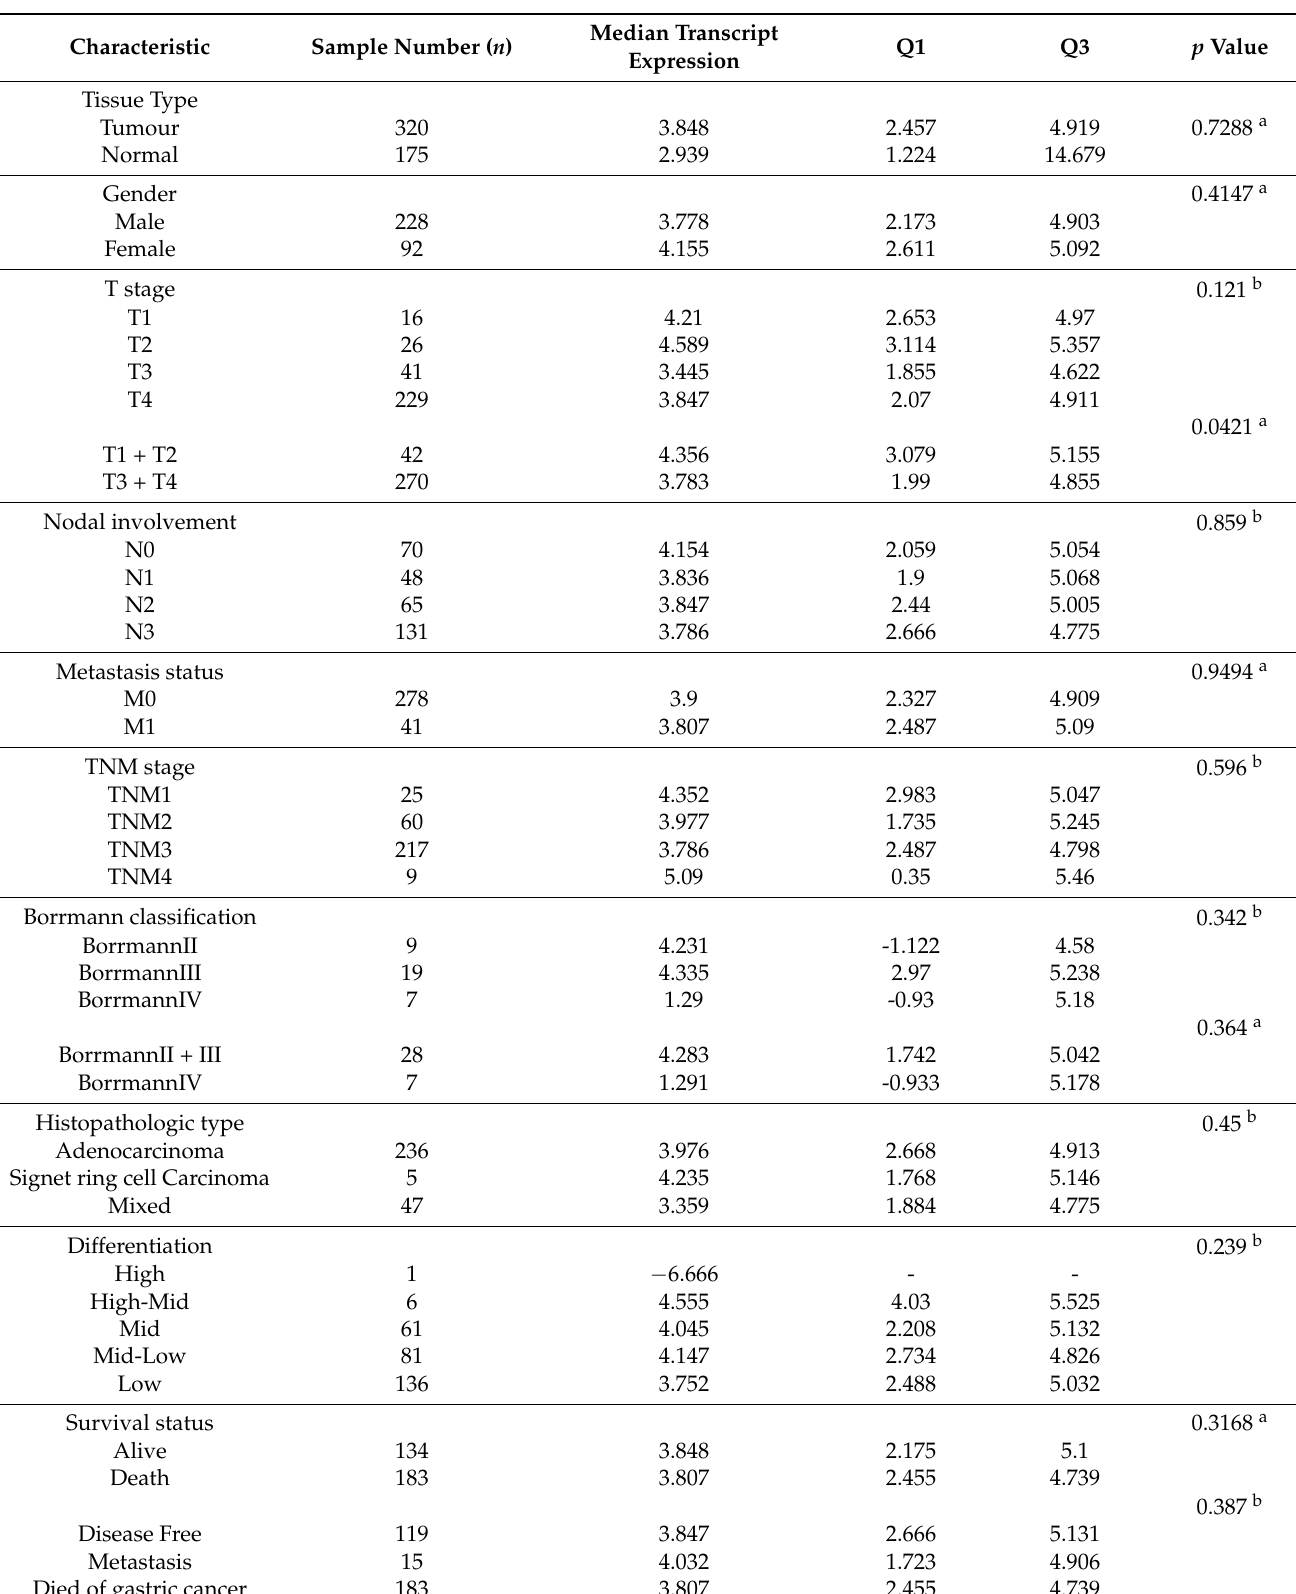
Table 1. Epithelial protein lost in neoplasm (EPLIN) log 10 relative transcript expression in gastric cancer and normal